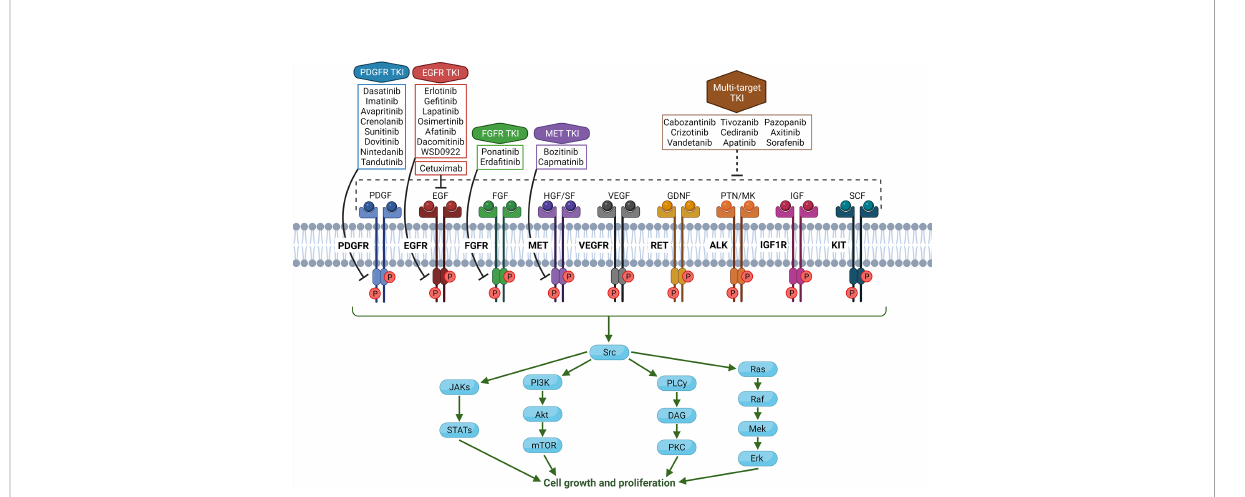
FIGURE 1 Schema of common and targetable receptor tyrosine kinases (RTKs) in the human body, along with associated tyrosine kinase inhibitors (TKIs). In glioma cells, overexpression, mutation, or ampli fi cation of RTKs can lead to tumorigenic phenotype. Note that all TKIs have varying degrees of off-target effects on other RTKs or kinases in the cell, and TKIs being speci fi c to one receptor is an oversimpli fi cation. (Created with